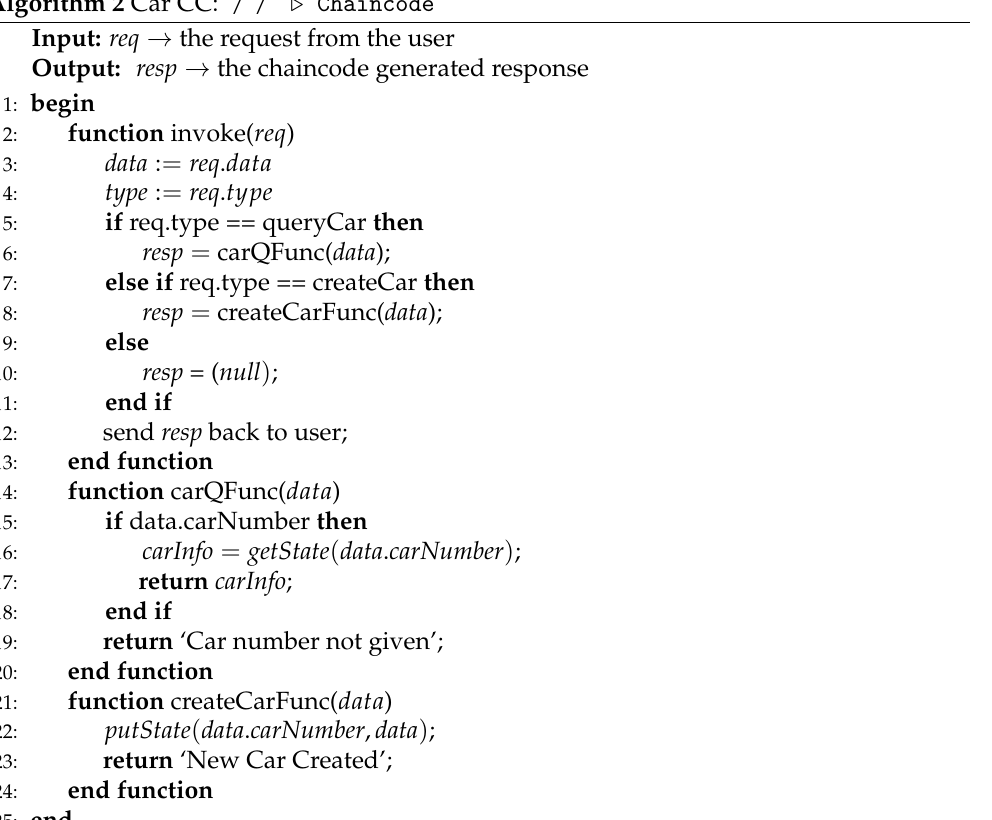
Algorithm 2 Car CC: / / (cid:46)